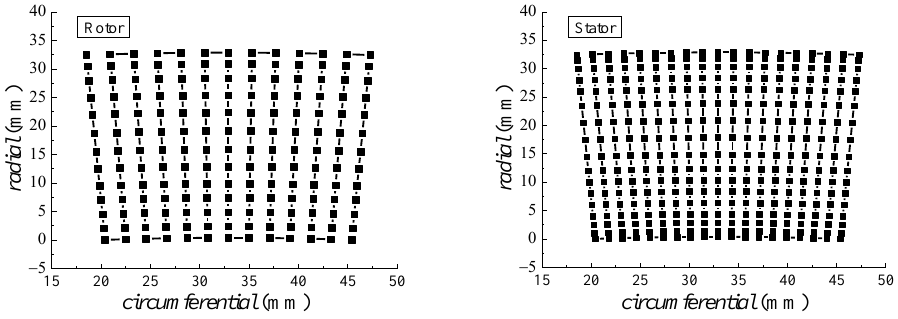
Figure 4. The arrangement of measurement points at the rotor and stator outlet.